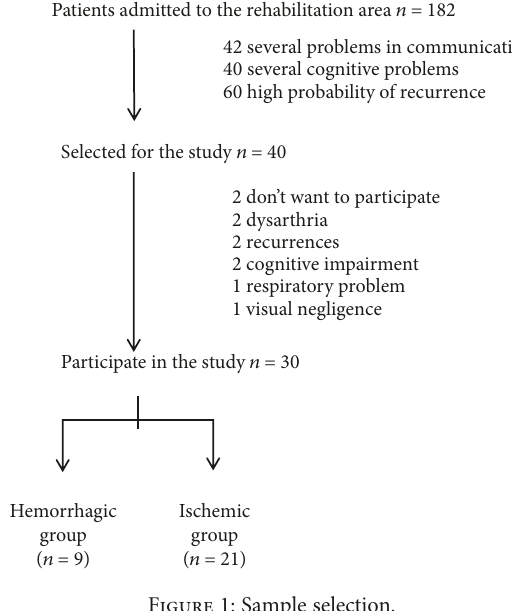
Figure 1: Sample